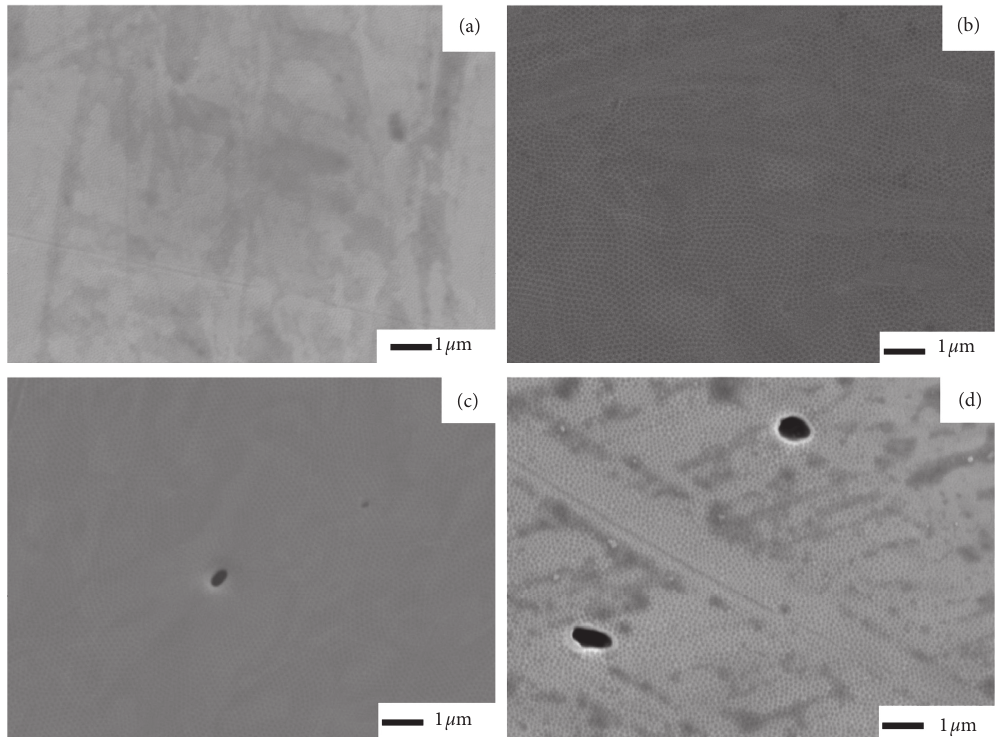
Figure 2: SEM images of stainless steel samples anodized under different HClO and (d) 9